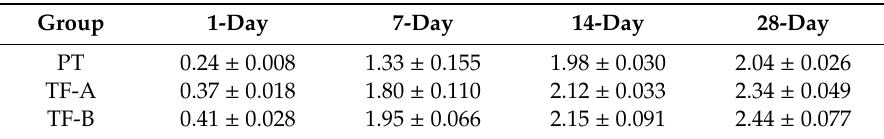
Table 2. Tensile strength at di ff erent curing periods (MPa).